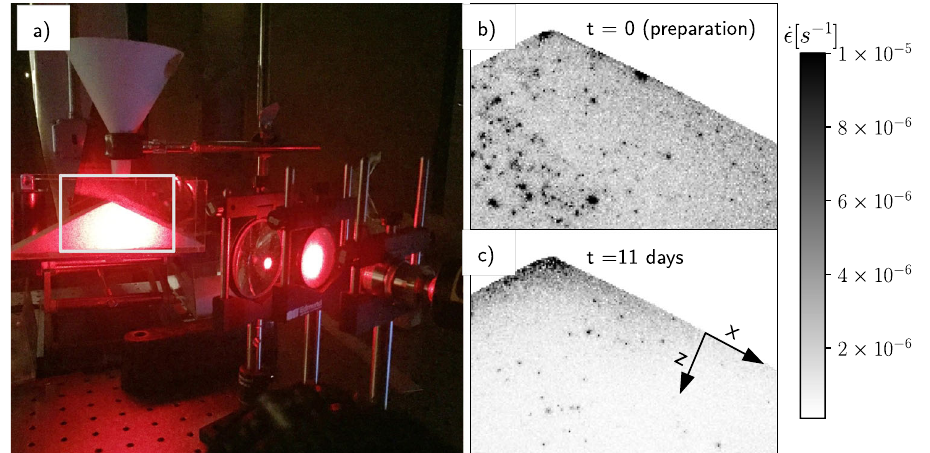
Fig. 2 Experimental setup and phenomenology. a DWS setup: an expanded laser beam is projected onto a granular heap; a camera collects speckle images from within the white rectangle. b Strain-rate map at t = 0, the moment after the pile is prepared, and ( c ) 11 days after preparation showing that particle